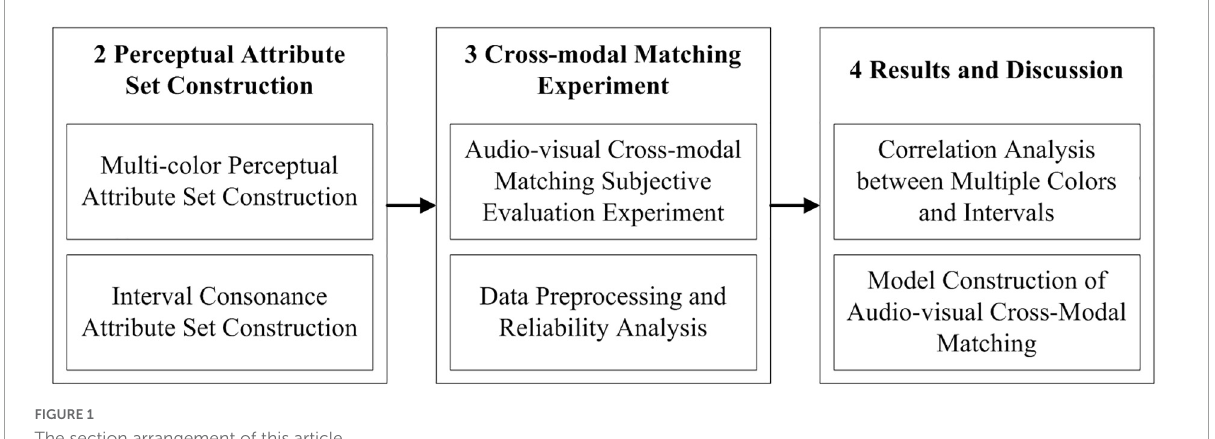
FIGURE1 The section arrangement of this